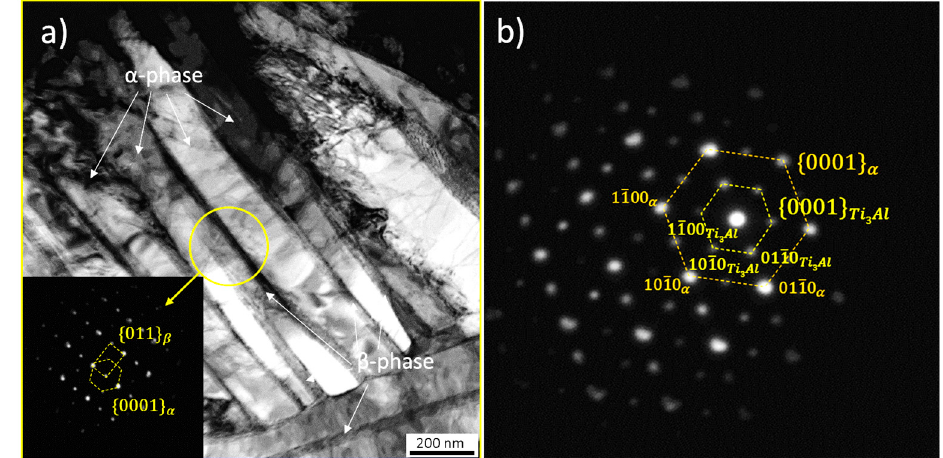
Figure 2. ( a ) Bright field transmission electron microscopy (TEM) image showing the ultrafine α + β microstructure formed at the center of a Ti-64 SLM sample (see z ~ 5 mm in Figure 1). The inset shows the Burger’s orientation relationship {011} β // {0001} α between crystal lattices; ( b ) Selected area electron diffraction pattern revealing the presence of α 2 -Ti 3 Al within an α lamella.